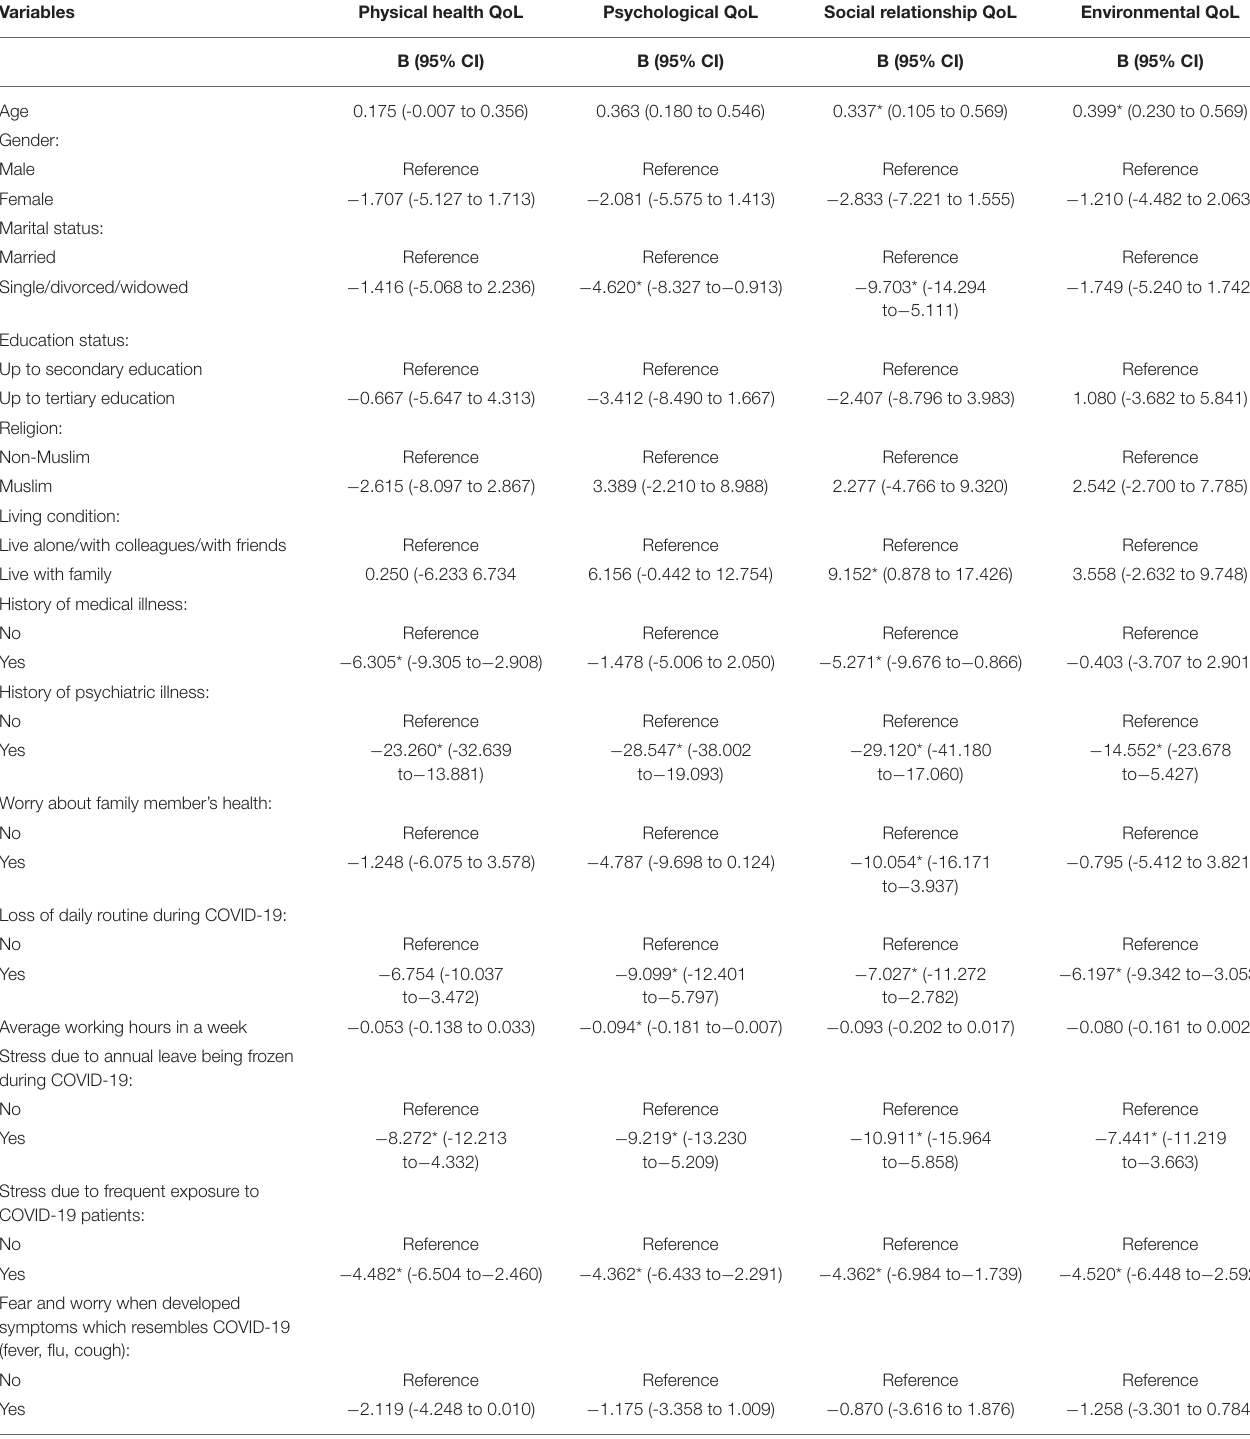
TABLE 2 | The association between individual demographic, personal, clinical characteristics, COVID-19 related factors, psychological characteristics, perceived social support, and the WHOQoL-BREF domains score among the respondents.